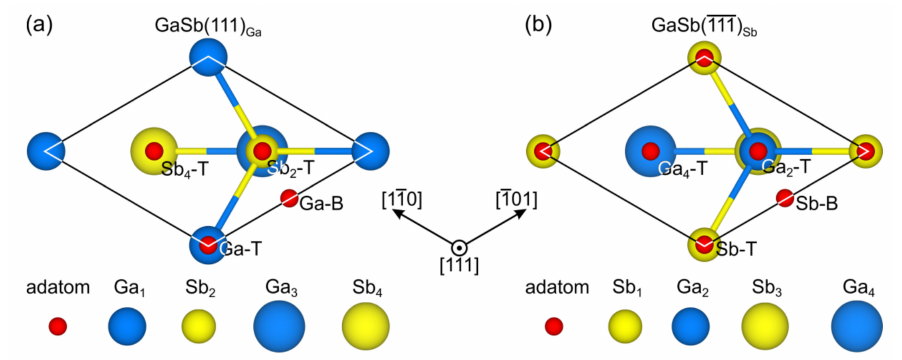
Figure 4. Atomic structure of the GaSb(111) Ga ( a ) and GaSb(111) Sb ( b ) surfaces (top view) and the considered adsorption positions of oxygen (or fluorine).